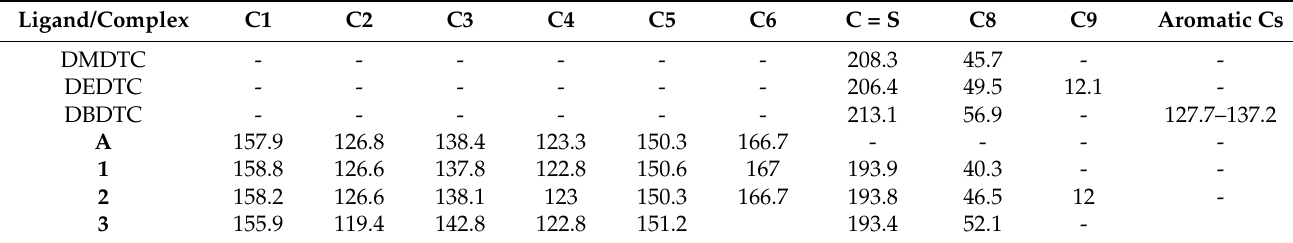
Table 3. 13 C-NMR chemical shifts for free ligands and their complexes in DMSO- d 6